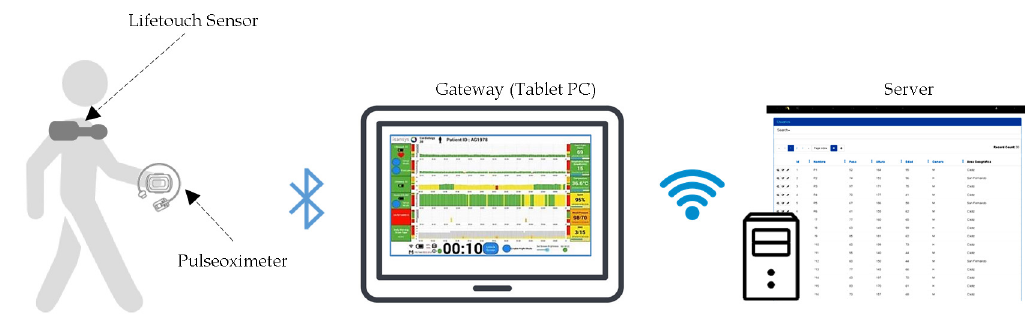
Figure 2. Functional architecture of the monitoring system architecture used in the effort tests.